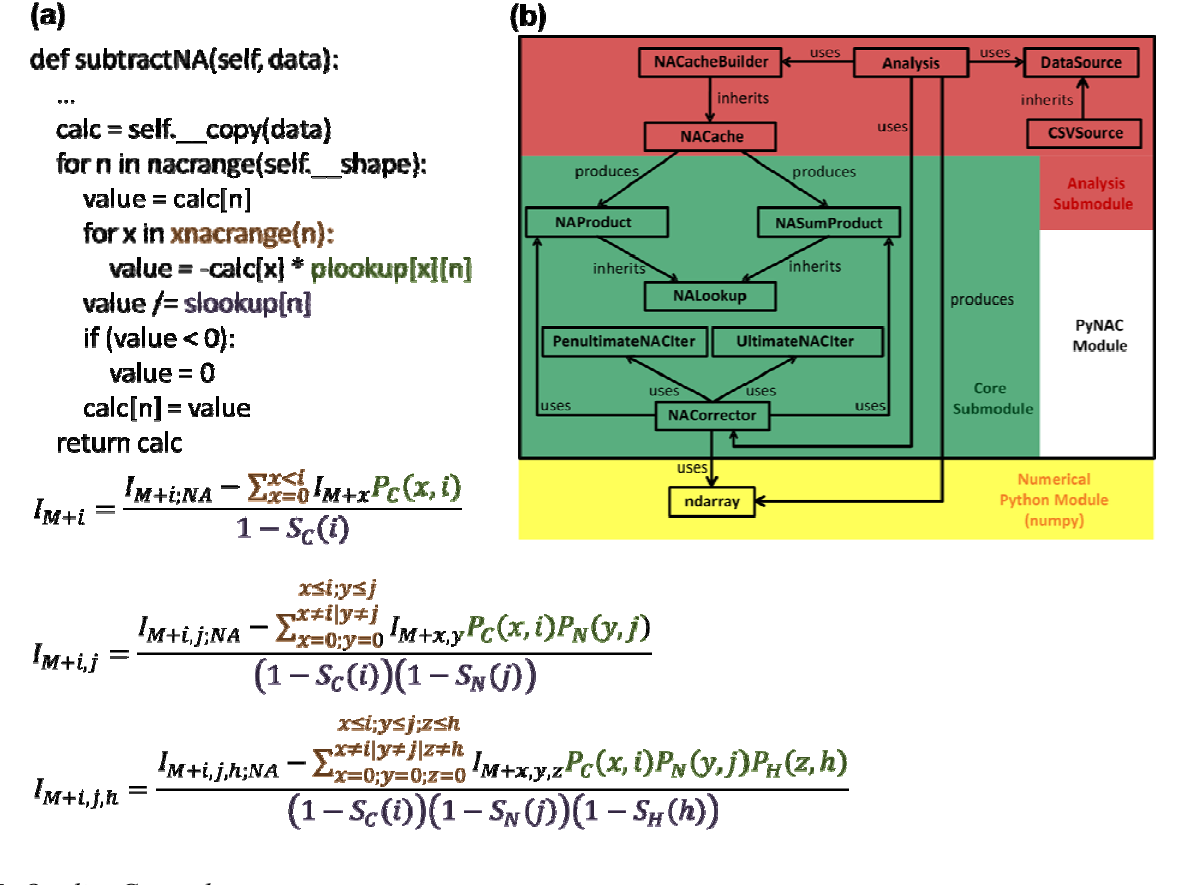
Figure 2. Algorithm generalization and class relations in the modularization of the code. ( a ) The orange xnacrange object is generalized to handle the different summations in each formula. The light green plookup object generalizes the P table representing different sets of binomial terms specific to each formula. The purple slookup object generalizes the S table representing different sets of summative binomial terms specific to each formula. ( b ) The PyNAC module has several classes separated into the green Core submodule or the red Analysis submodule. The blue multiprocessing module is provided by the standard Python language library. The yellow numpy module is the only additional python library that is necessary. The NACorrector class implements the main correction algorithm using the ndarray class from the nympy module. The PenultimateNACIter, NAProduct, and NASumProduct classes implement the orange xnacrange, light green plookup, and purple slookup